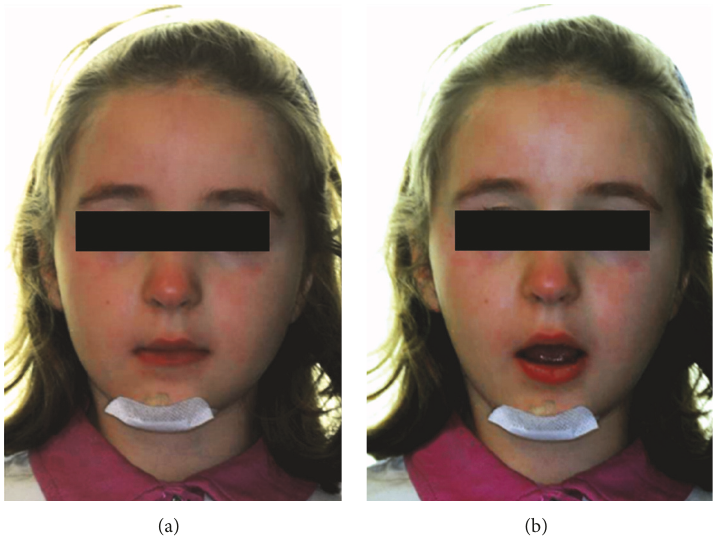
Figure 1: (a, b) Frontal view of the face and limitation in mouth opening.